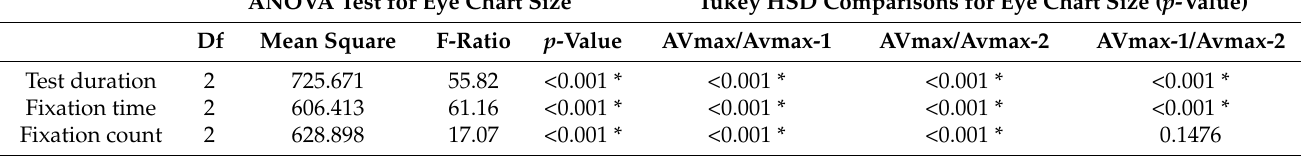
Figure 4. Variations in test duration, complete fixation time, and fixation count depend on the interactions of eye chart size and gaze direction ( A ), the gaze directions and PPL ( B ), and PPL and eye chart ( C ) for far-distance VA tasks. * Shows significance at the 0.05 level. Table 2. Detailed statistics for Figure 4. Three-way repeated measures ANOVA test with pos-hoc comparisons using Tukey HSD method. * Shows significance at the 0.05 level. ANOVA Test for Eye Chart